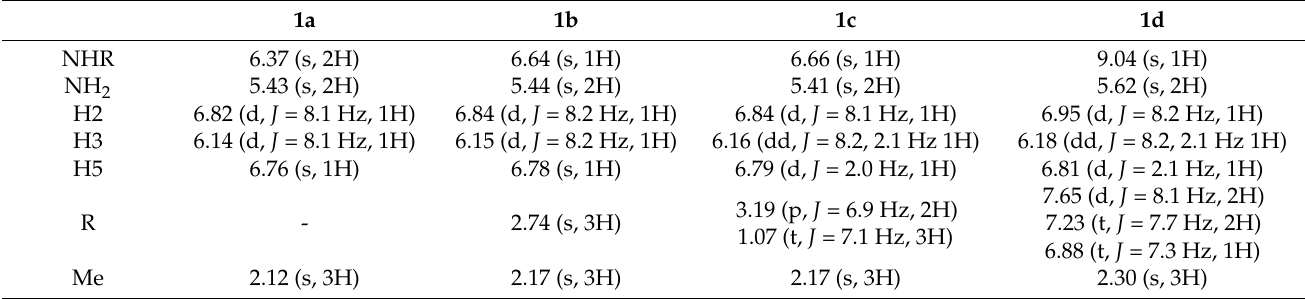
Table 2. Table 2. Assignation of the NMR signals of compounds 1a – d